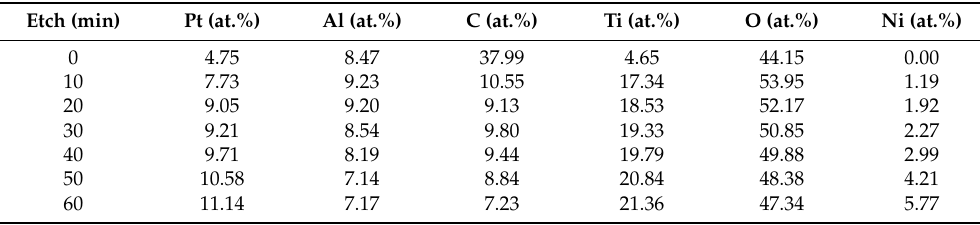
Figure 8. The measured and fitted XPS spectra attributed to O before etching ( a ) and after 30 min of Ar n+ etching ( b ). Table 2. Atomic percentages of the elements at the surface of sample Pt200 determined from the XPS after various times of Ar n+ etch.